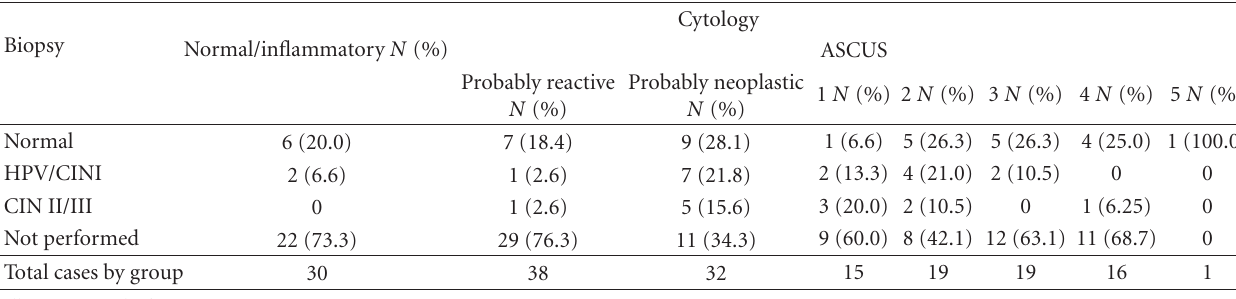
Table 3: Results of biopsies performed on patients with an initial diagnosis of ASCUS who, upon review, were reclassified as having normal/inflammatory cytology, probably reactive ASCUS, and probably neoplastic ASCUS, and who, in accordance with the Regione Emilia Romagna (ASCUS 1 to 5), showed evidence of changes in the colposcopic exam.